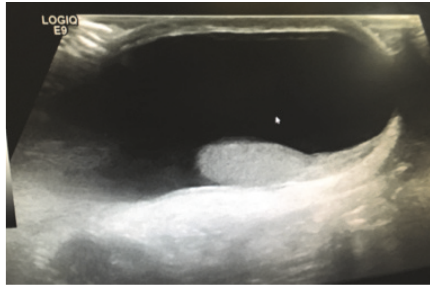
Figure 1: Ultrasound examination. Sagittal image of the left scrotal mass demonstrating the difficulty to appreciate the full extent of the abnormality.